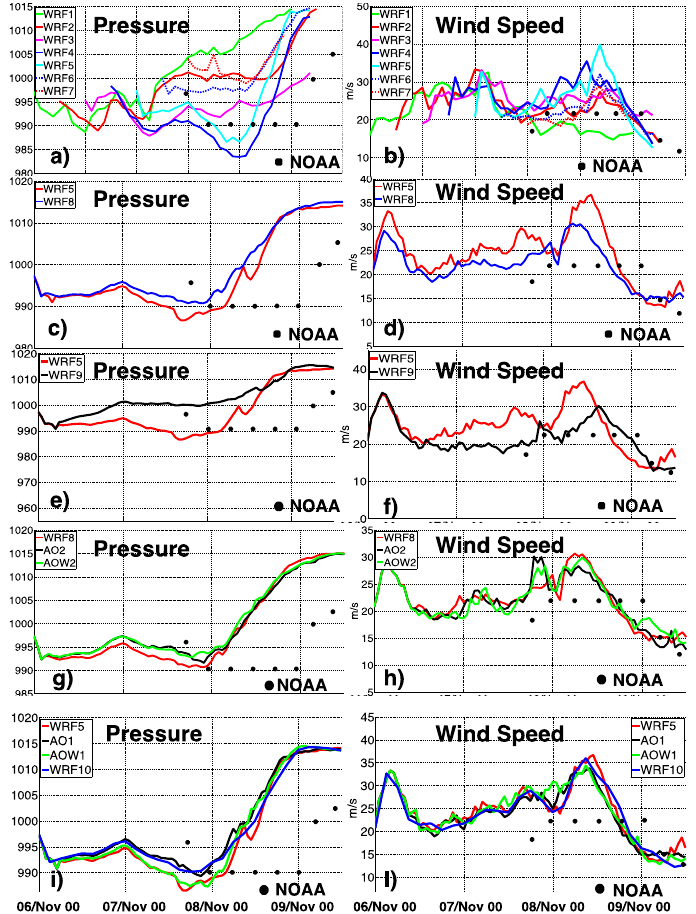
Figure 8. Time evolution of the pressure minimum (in hPa) and the maximum wind speed (m/s) around the eye, as resulting from different experiments. Black dots represent estimated NOAA data for the pressure minimum of the cyclone and wind speed around the minimum. Panels ( a ) and ( b ): comparison between the evolutions of the various WRF1-7 runs for the pressure minimum and wind intensity. Panels ( c ) and ( d ): comparison between WRF5 and WRF8 (using, respectively, MYJ and MYNN PBL schemes). Panels ( e ) and ( f ): results from WRF5 and WRF9 (SST spectrum radiometer and SST +3 °C). Panels ( g ) and ( h ): comparison among runs WRF8, AO2, AOW2, with MYNN PBL scheme. Panels ( i ) and ( l ): results for runs WRF5, WRF10, AO1, AOW1.